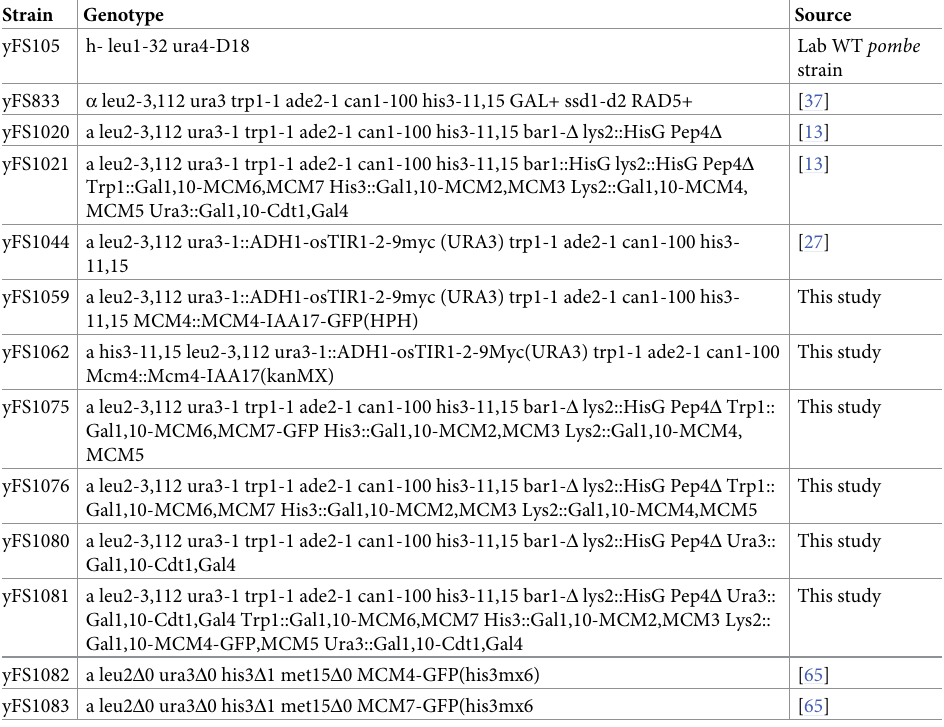
Table 1. Strains